Question: According to the figure, is the described quantity increasing or decreasing?
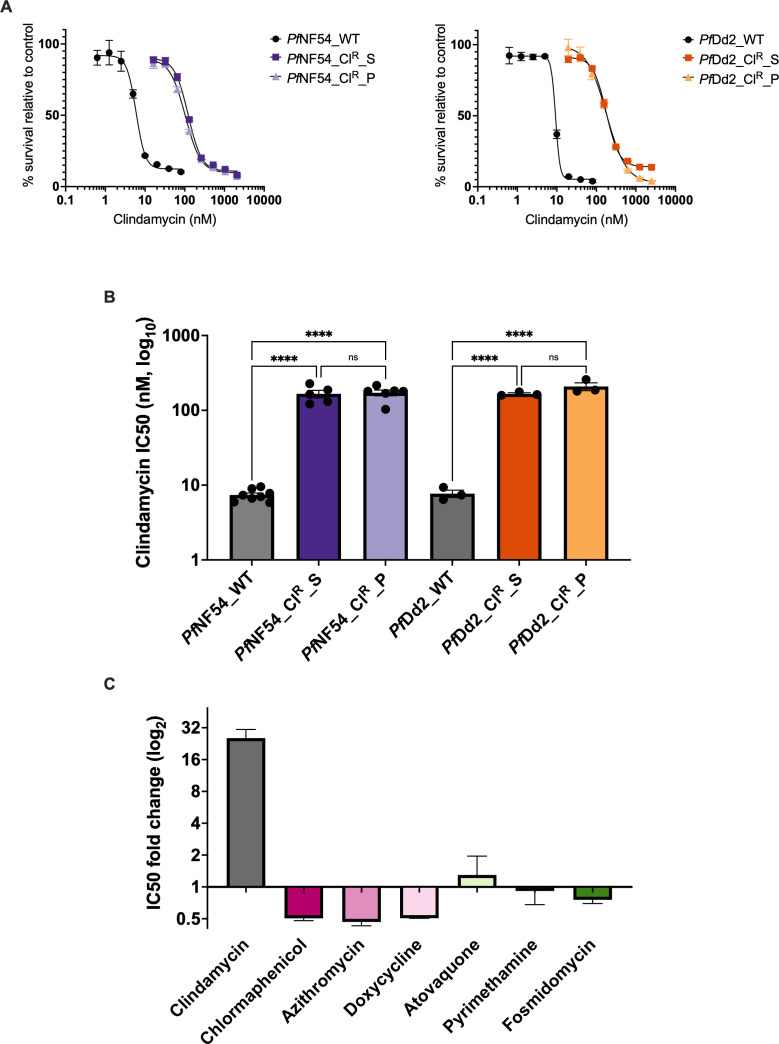
Answer: increasing